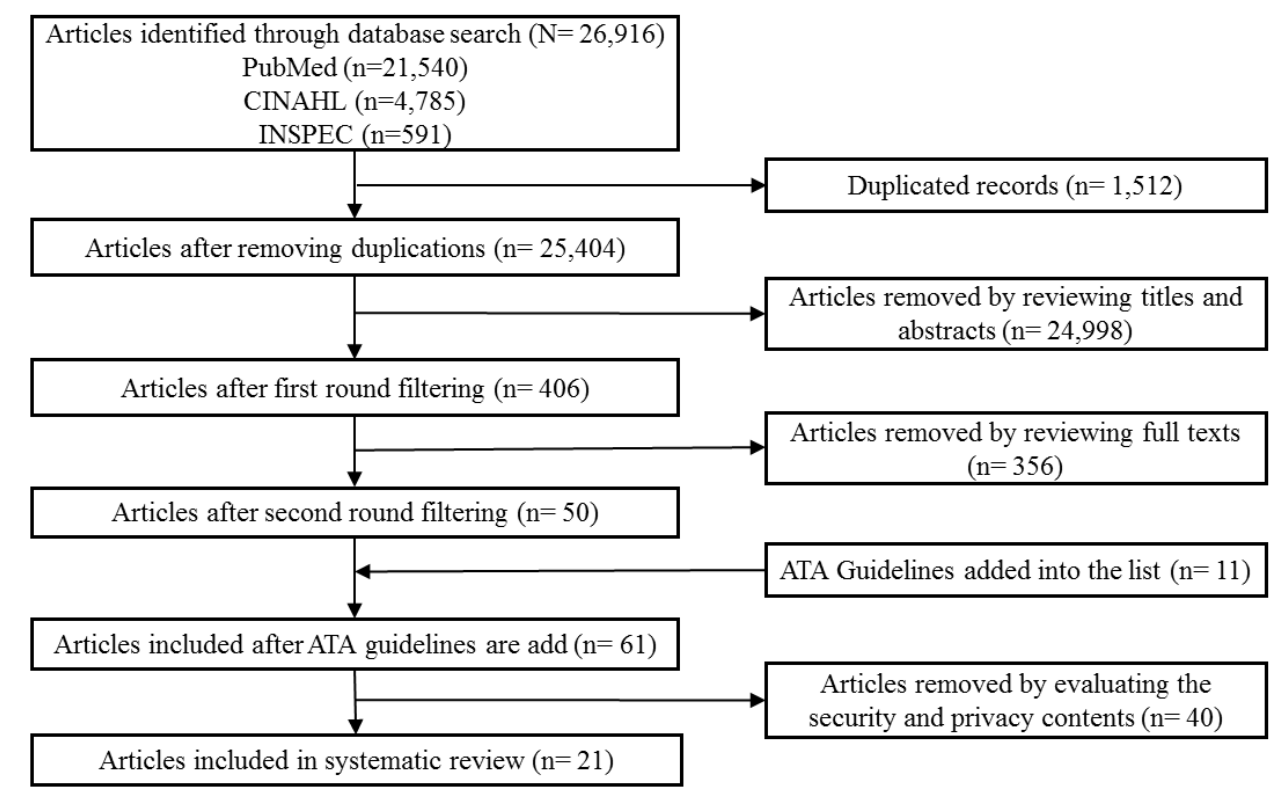
Figure 1. A flow diagram of the search and selection